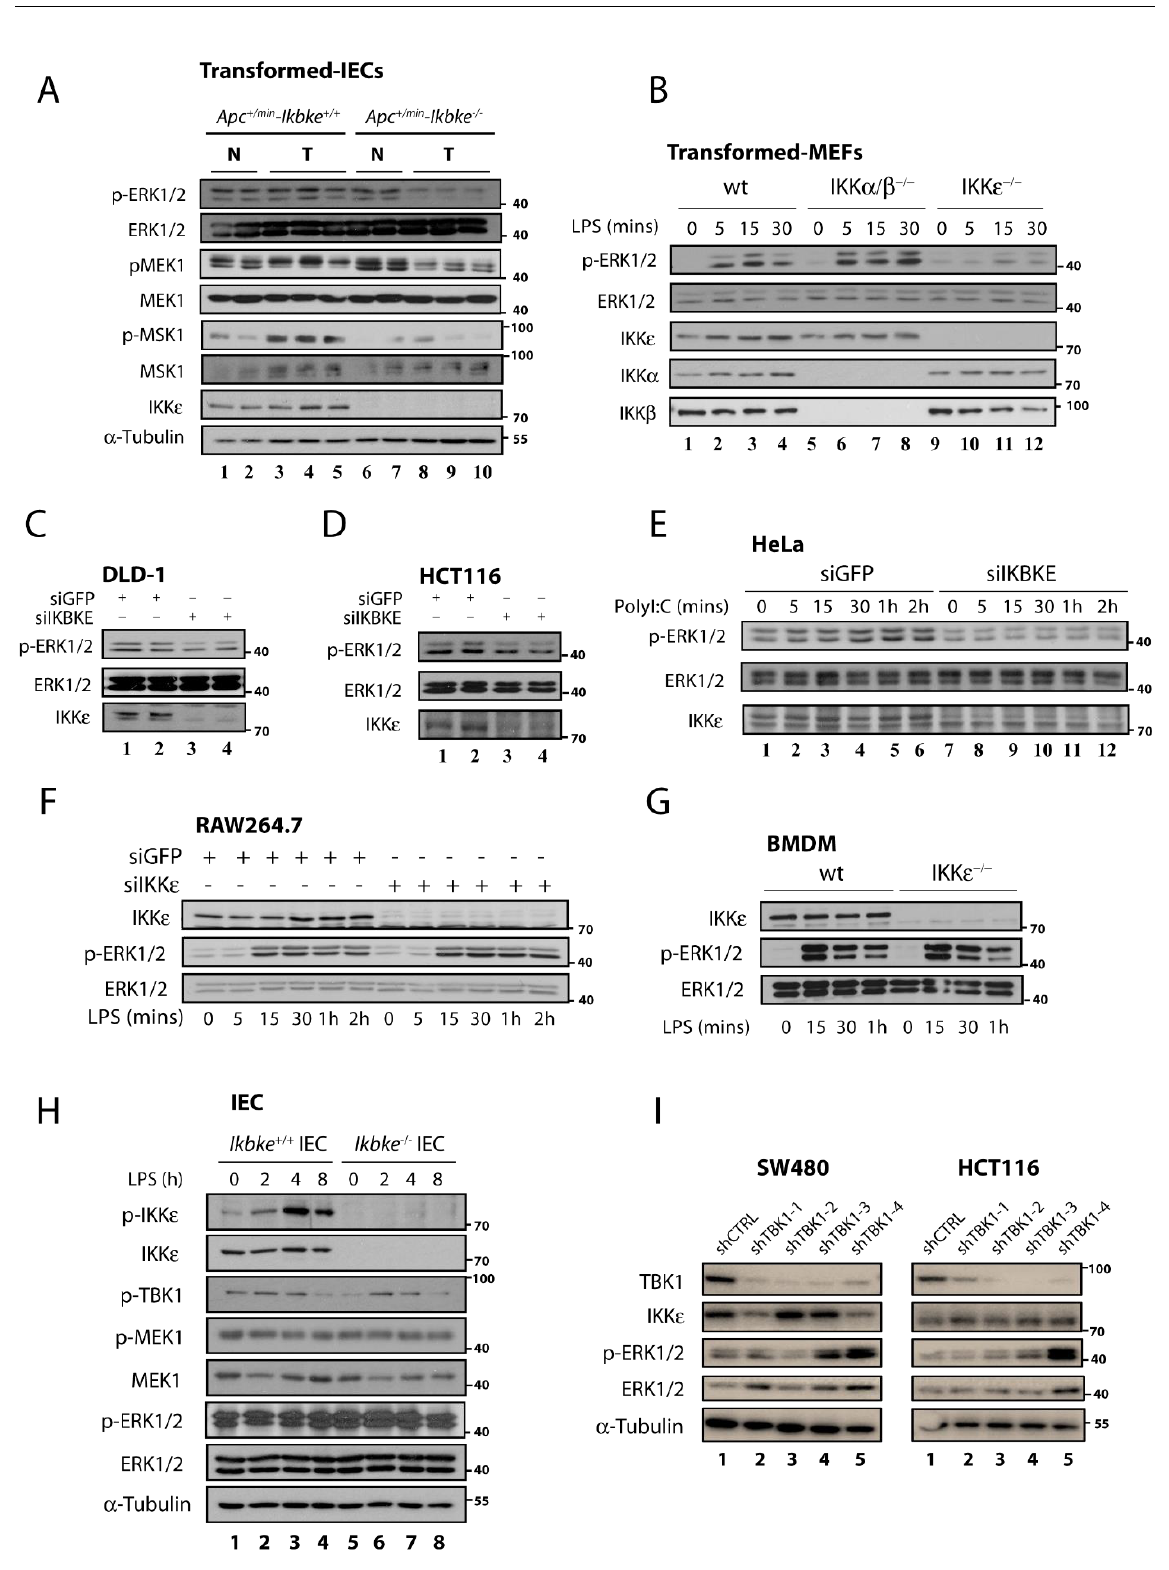
Figure 1: ERK1/2 activations are abrogated in IKKɛ deficient tumor cells from various tissues. (A) ERK1/2 and MEK1 constitutive phosphorylations are diminished in IKBKE deficient IECs from Apc +/min mice but only in tumor samples. (B) Transformed MEF cells deficient of only IKBKE (but not in IKKα or IKKβ) also show abrogated ERK1/2 phosphorylation (where different genotypes of MEF cells were stimulated 0-30 minutes, at indicated time points, with 10 ng/ml LPS). (C-E) Tumor cell lines from various epithelial neoplasia also show diminished ERK1/2 phosphorylation upon loss of IKBKE